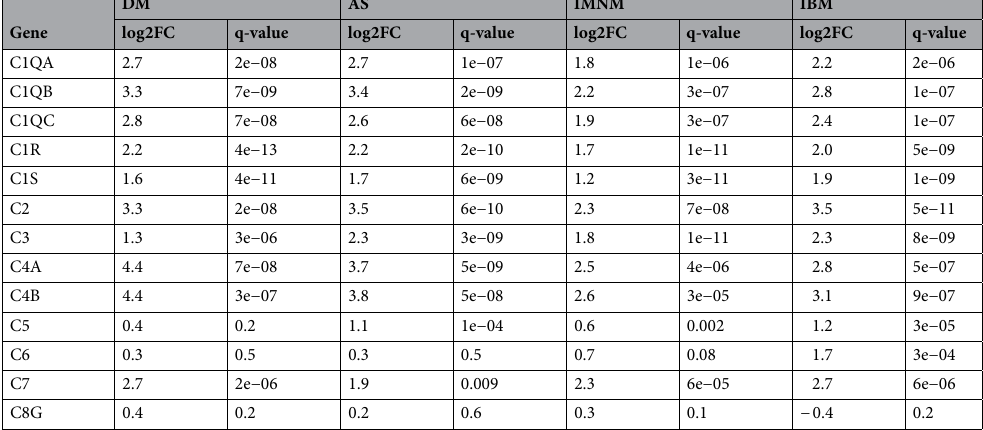
Table 1. Expression of complement genes in the different types of inflammatory myopathy compared to normal muscle. These genes did not pass the cutoff for differential expression: C8A, C8B, C9. DM dermatomyositis; AS Antisynthetase syndrome; IMNM Immune-mediated necrotizing myositis; IBM Inclusion body myositis.